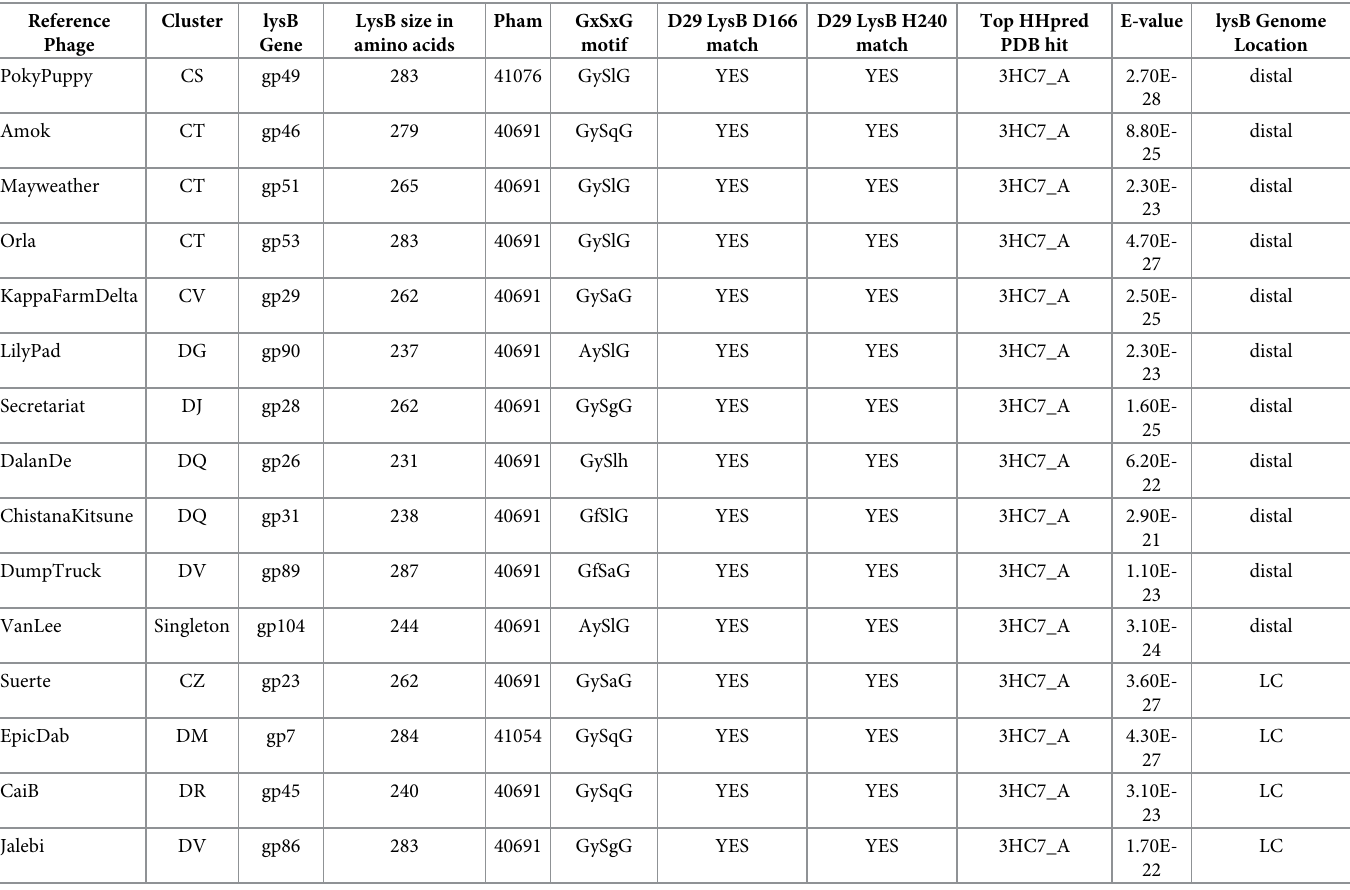
Table 4. Identification and characterization of lysB genes and